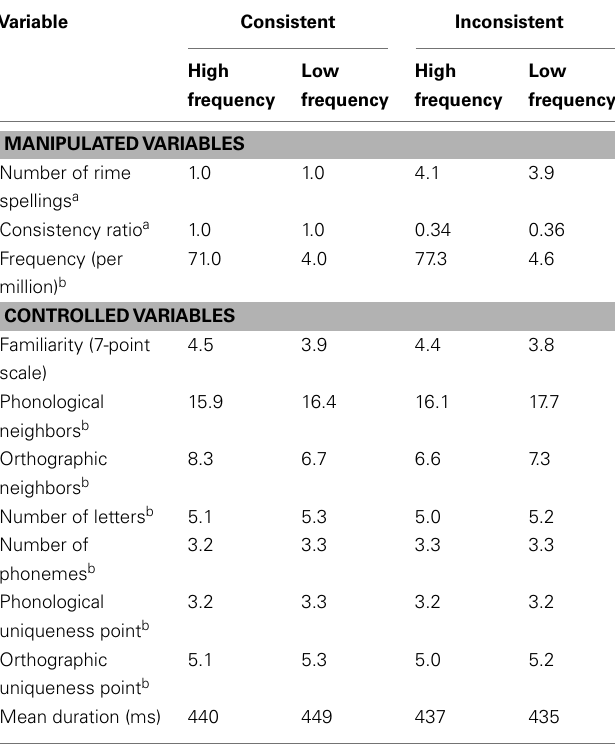
Table 2 | Stimulus characteristics of words used in Experiment 1 (lexical decision) manipulating orthographic consistency and word